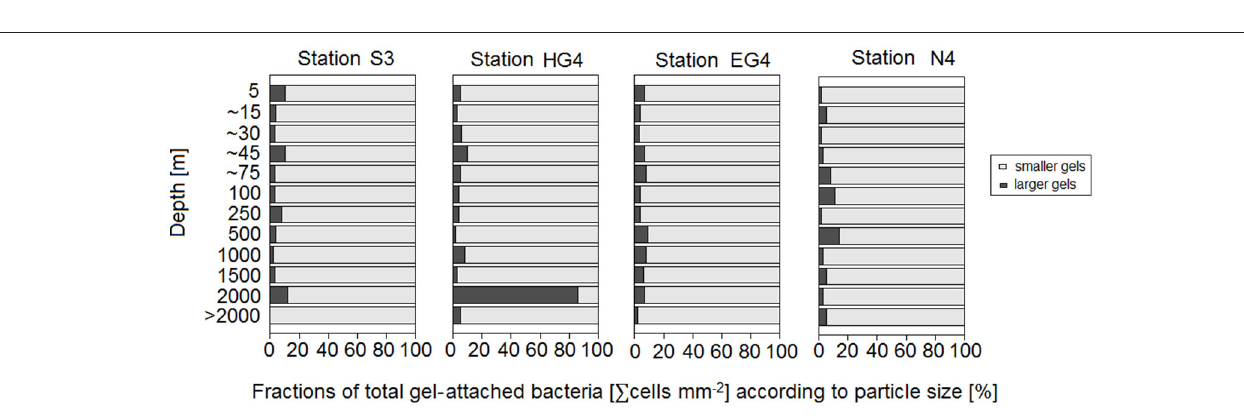
FIGURE 8 | Percentages of total gel-attached bacteria ( cells mm − 2 ) according to particle size. Smaller gels, which means 1–10 µ m ESD, are depicted in light gray. P Larger gels, which means 10.5–33.5 µ m ESD, are shown in dark gray. Results are presented for all sampling depths and all stations. Depths indicated with “ ∼ ” represent medians of the four stations (as sampling depths in the euphotic zone were slightly adjusted at each station to sample the chlorophyll maximum and its gradient). “ > 2,000 m” refers to depths below 2,000